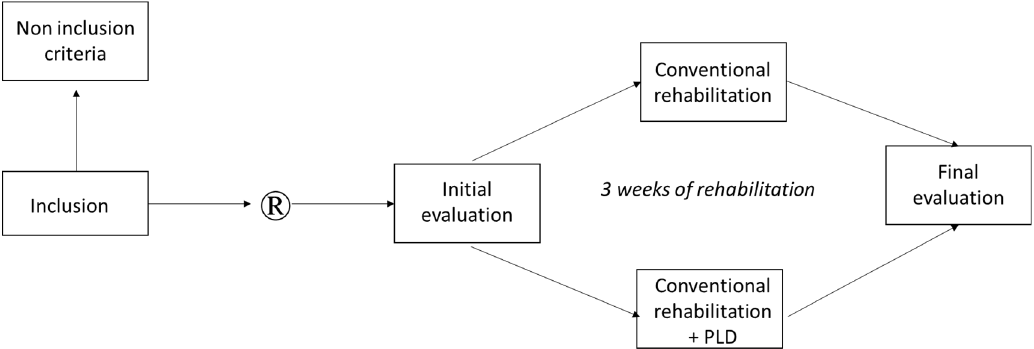
Figure 2. Experimental design.